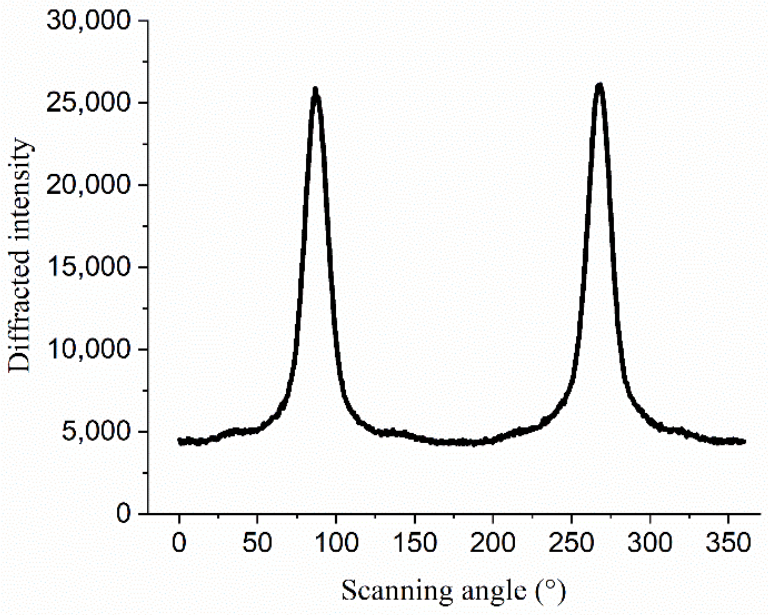
Figure 2. Bimodal diagram of microfibril angle determined.